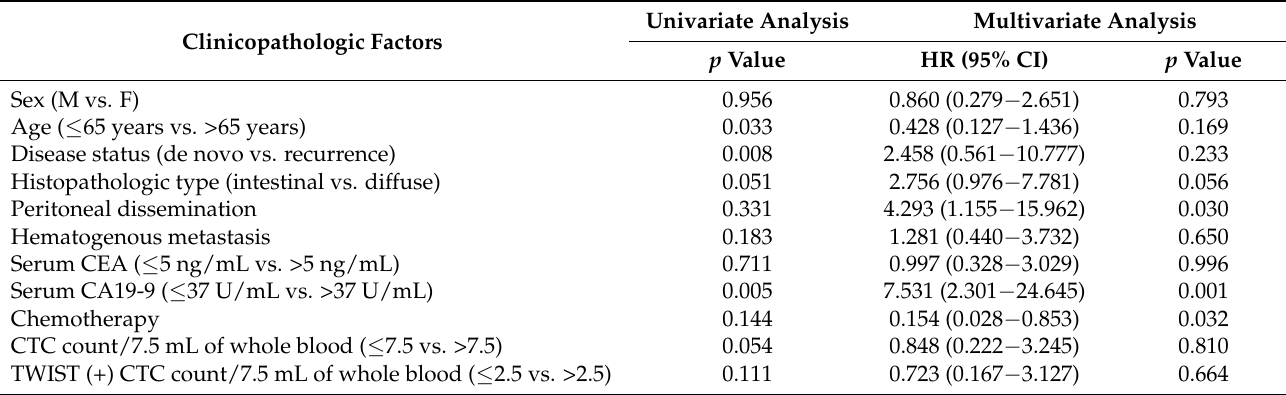
Table 4. Univariate and multivariate analyses of clinicopathologic factors for overall survival in the 31 patients with metastatic gastric